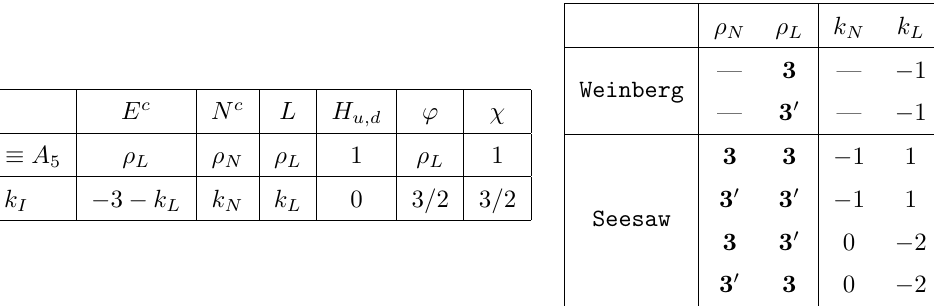
Table 3 . Chiral supermultiplets, transformation properties and weights for the level-5 models.